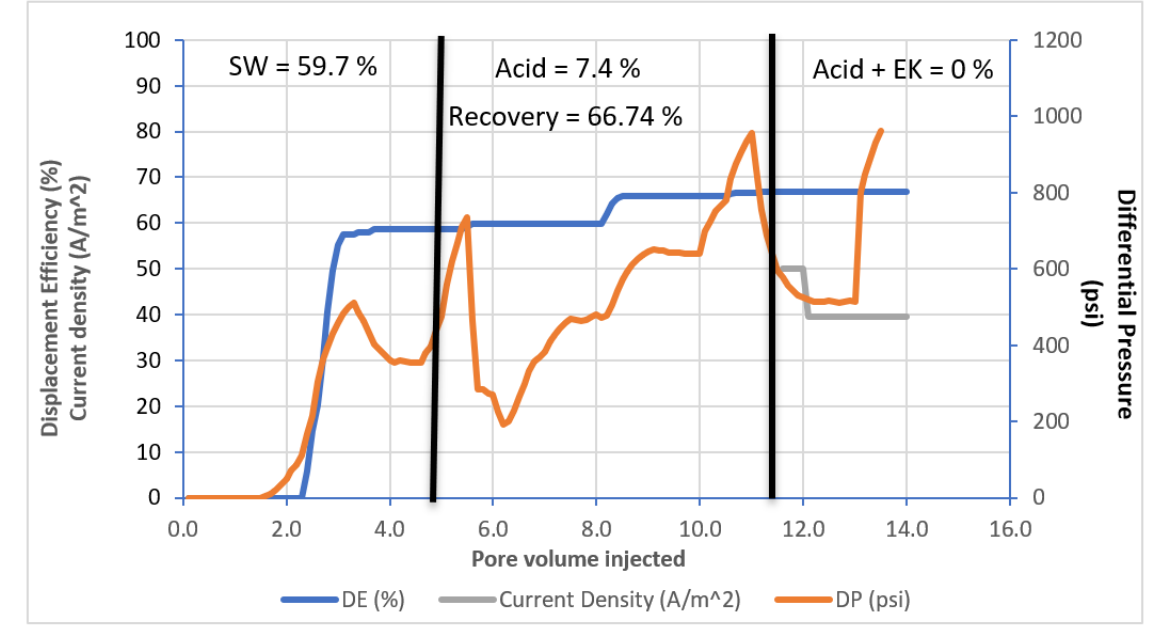
Figure 2. DE, DP ( ∆ P), Current Density vs. Pore Volume Injected for CF1. Figure 2. DE, DP (ΔP), Current Density vs. Pore Volume Injected for CF1 . At the secondary stage, a total 5.5 pore volumes of seawater were injected initially, CF2 producing 59.7% of oil. Afterwards, the injection fluid was switched to 6% acid diluted in seawater, showing a 7.4% incremental displacement efficiency in tertiary stage. EK with acid effect was applied in quaternary stage. Maximum current density was set to 50 tion at this stage. This might be because pre-flushes make relative oil permeability reach Table 9. Summary of